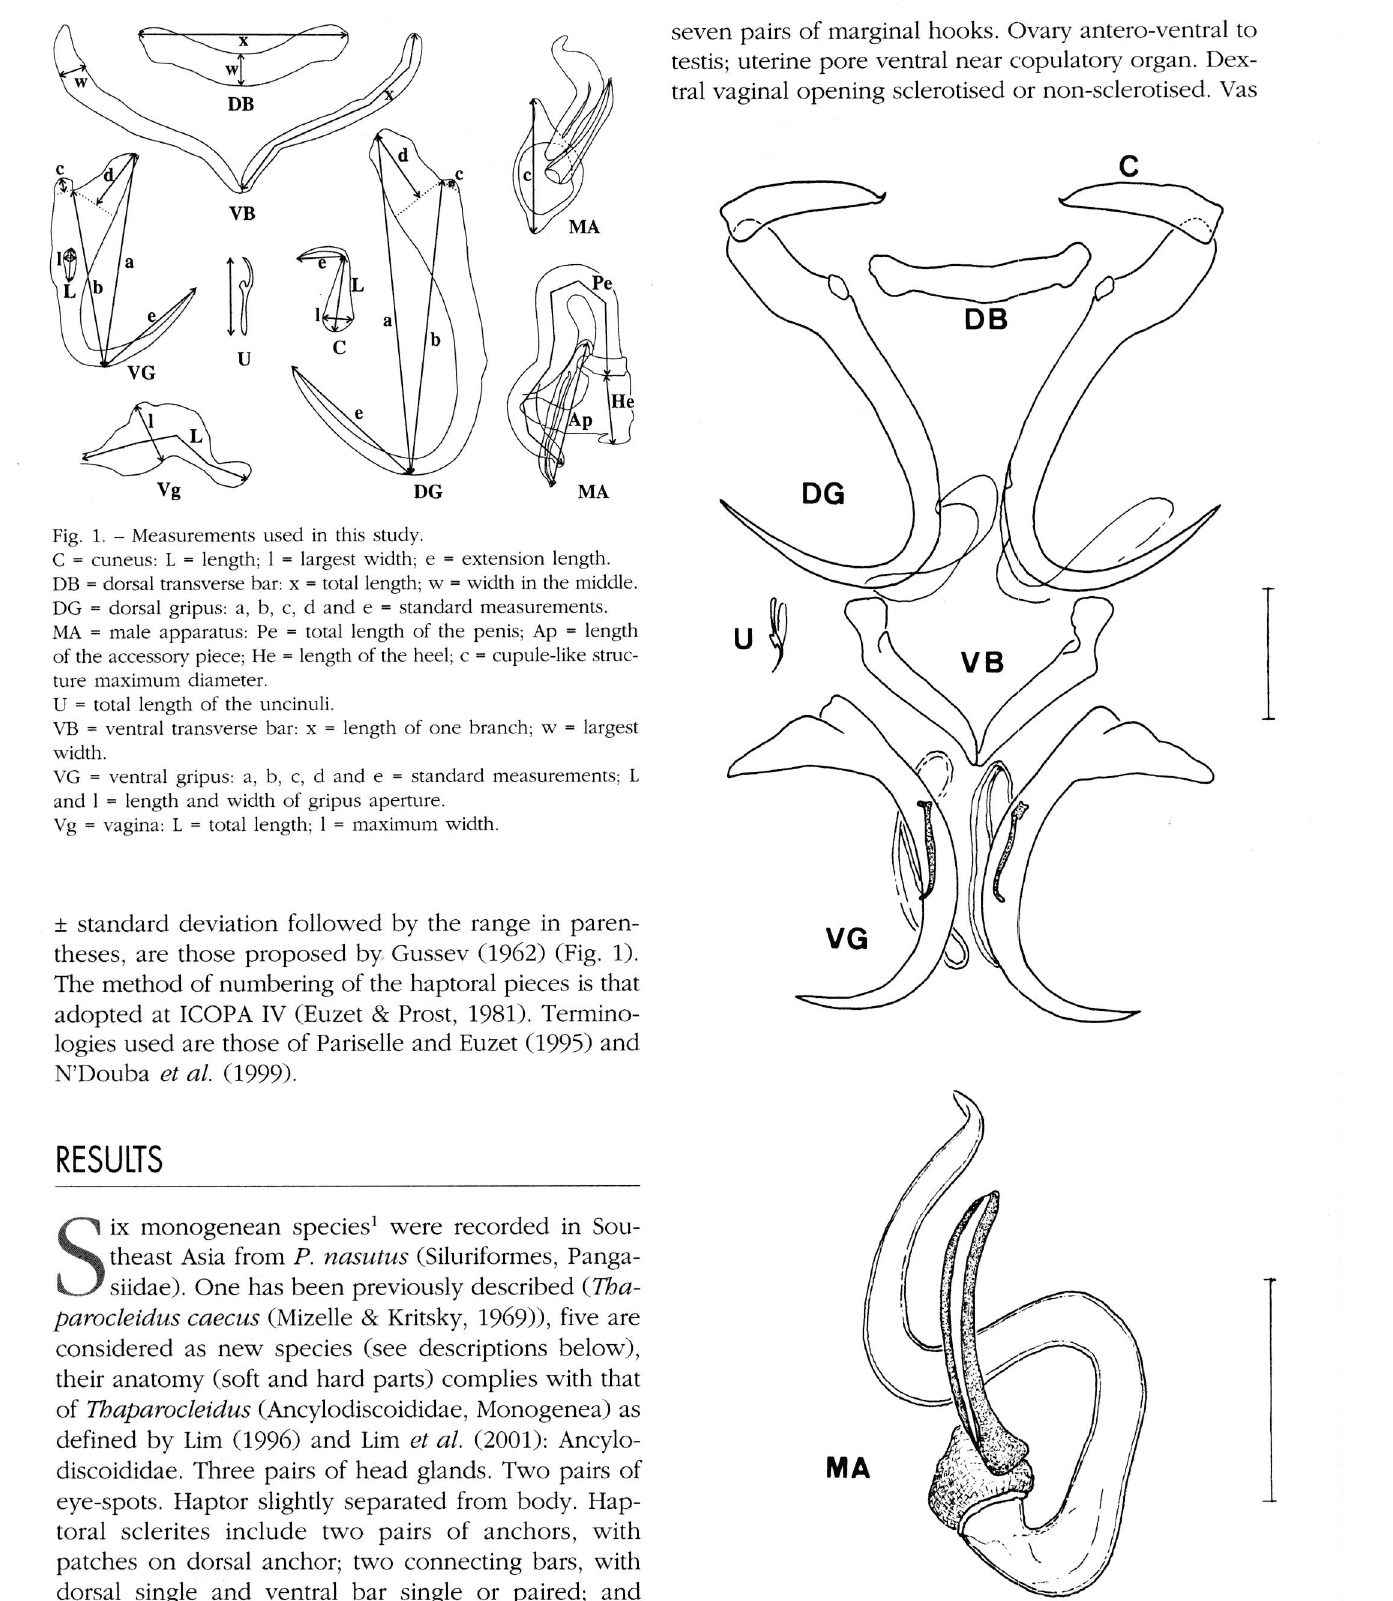
Fig. 2. - Thaparocleidus serpens n. sp. C = cuneus; DB = dorsal trans verse bar; DG = dorsal gripus; MA = male apparatus; VB = ventral transverse bar; VG = ventral gripus, U = uncinulus. Bar = 30